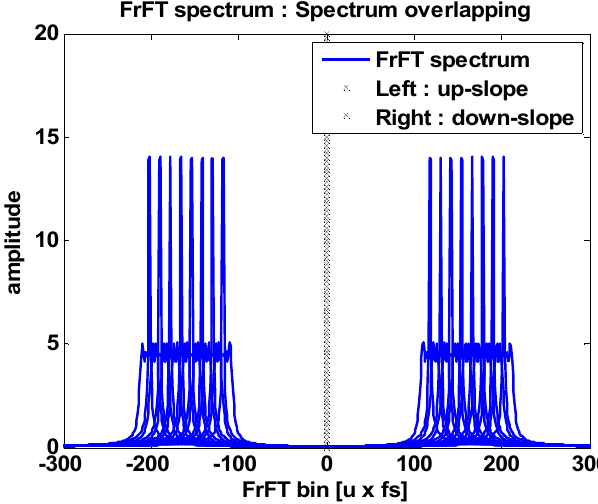
Figure 7. Aggregate FrFT spectra for all frequency bins.